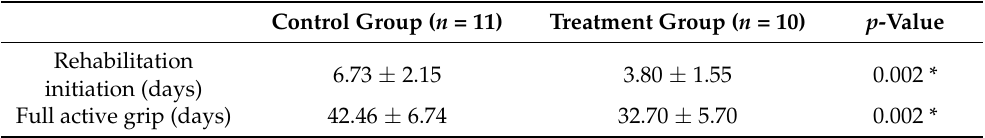
Figure 2. The distance between the fingertip and distal palmar crease (FPD) decreased in both groups over time. However, a significant difference was observed from the second week after surgery, which means that the active flexion was recovering faster in the treatment group. The speed at which the full active grip at which the distance between the fingertip and distal palmar crease became 0 was also achieved more quickly in the treatment group on average. * p- Value ≤ 0.05. Table 3. Summary of the start time of rehabilitation and the time of achieving a full active grip in both groups.